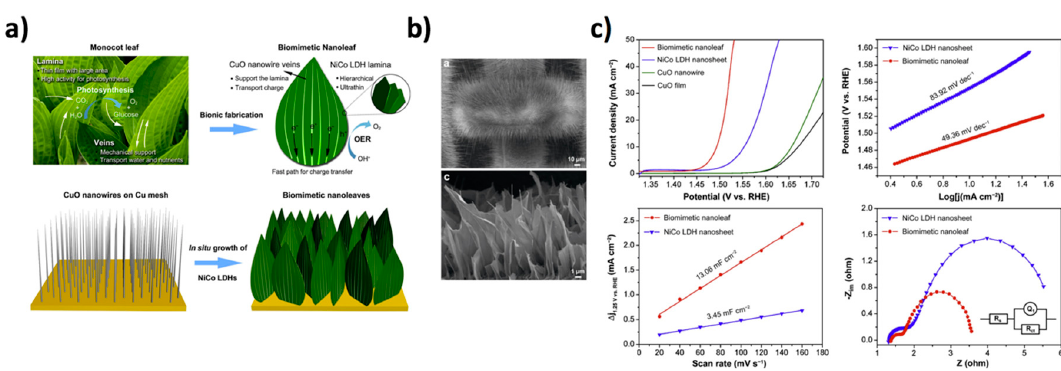
Figure 12. Biomimetic LDH nanoleaf for OER. ( a ) Schematic illustration of the biomimetic NiCo-LDH based nanoleaf, showing (top) a photograph of the monocot leaf and a sketch of the biomimetic nanoleaf, with indication of the OER process, and (bottom) the fabrication procedure, with in situ growth of NiCo-LDH on the CuO nanowires/Cu mesh substrate. ( b ) SEM images of the CuO nanowires on the Cu mesh (upper panel, scale bar 10 μ m), and of the biomimetic nanoleaves (bottom) (scale bar 1 μ m). ( c ) OER performance. First row: Linear sweep voltammetry (LSV) polarization curves (left); and corresponding Tafel plots (right). Second row: Capacitive current vs. scan rates (left); and Nyquist plots at an overpotential of 300 mV (0.1 Hz to 100 kHz) (right). Reprinted from Ref. [157] with permission from Elsevier.